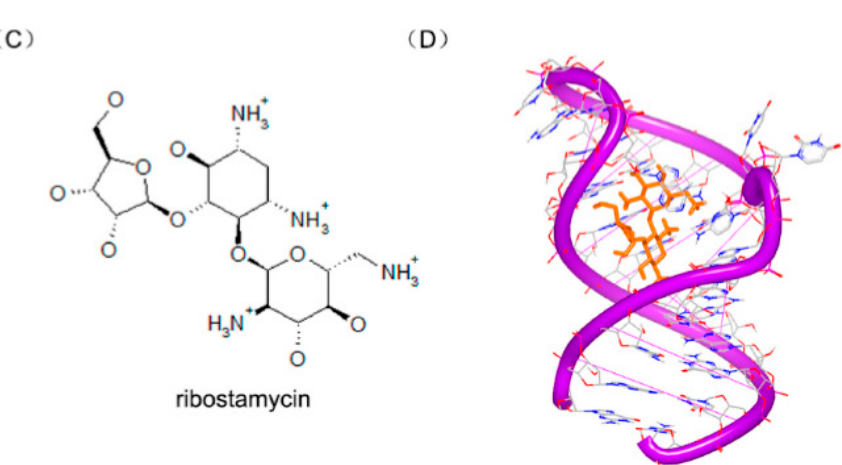
Figure 24. ( A ) Chemical structure of paromomycin; ( B ) complex of a neomycin riboswitch RNA with paromomycin (PDB code: 2MXS); ( C ) chemical structure of ribostamycin; and ( D ) complex of a neomycin riboswitch RNA with ribostamycin (PDB code: 2N0J). The orange structure represents the small molecule; the purple structure represents the backbone of nucleic acid; the blue and red atoms in the molecule represent nitrogen and oxygen atoms, respectively.